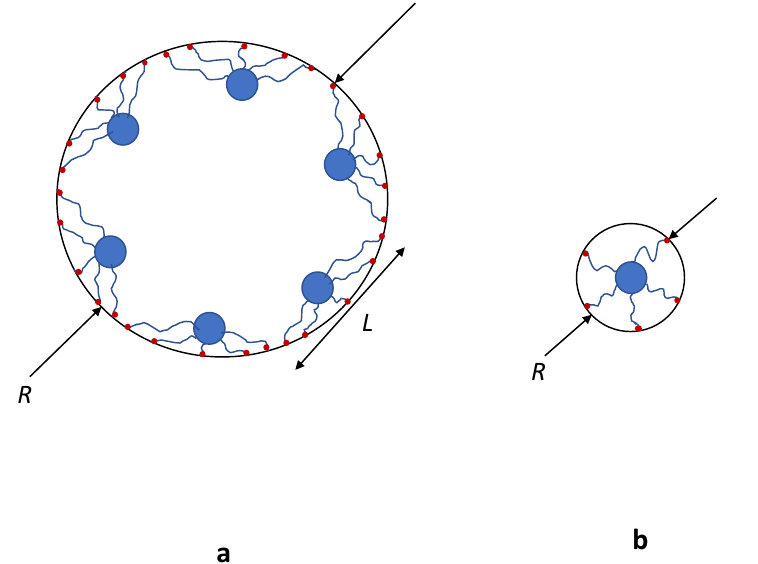
Figure 13. Schematics of clusters pinned in quasi-two dimensional ( a ) and quasi-one-dimensional ( b ) regime in a cylindrical